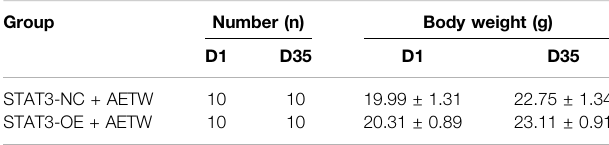
TABLE 6 | Tumor volume from mice of the two experiment groups (STAT3-NC + AETW, STAT3-OE + AETW). Group Tumor volume (mm 3 ) STAT3-NC + AETW 579 ± 140 STAT3-OE + AETW 811 ± 199** Compared with the STAT3-NC + AETW group, ** p < 0.01.